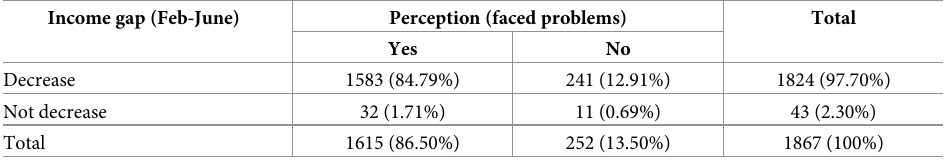
Table 8. Income downfall and perception validity test.